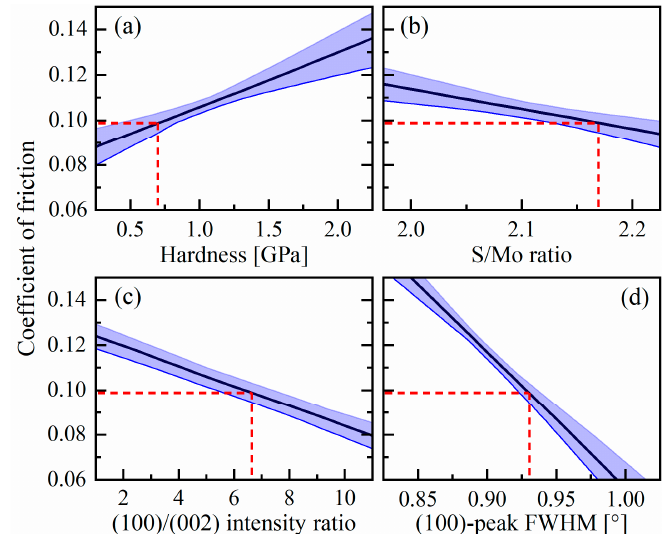
Figure 8. Impacts of significant film properties, ( a , b ), as well as XRD characteristics, ( c , d ), on the friction coefficient of the MoS x films, with the uncoated 100Cr6 counter body. The values marked by the red dashed lines belong to ID5.